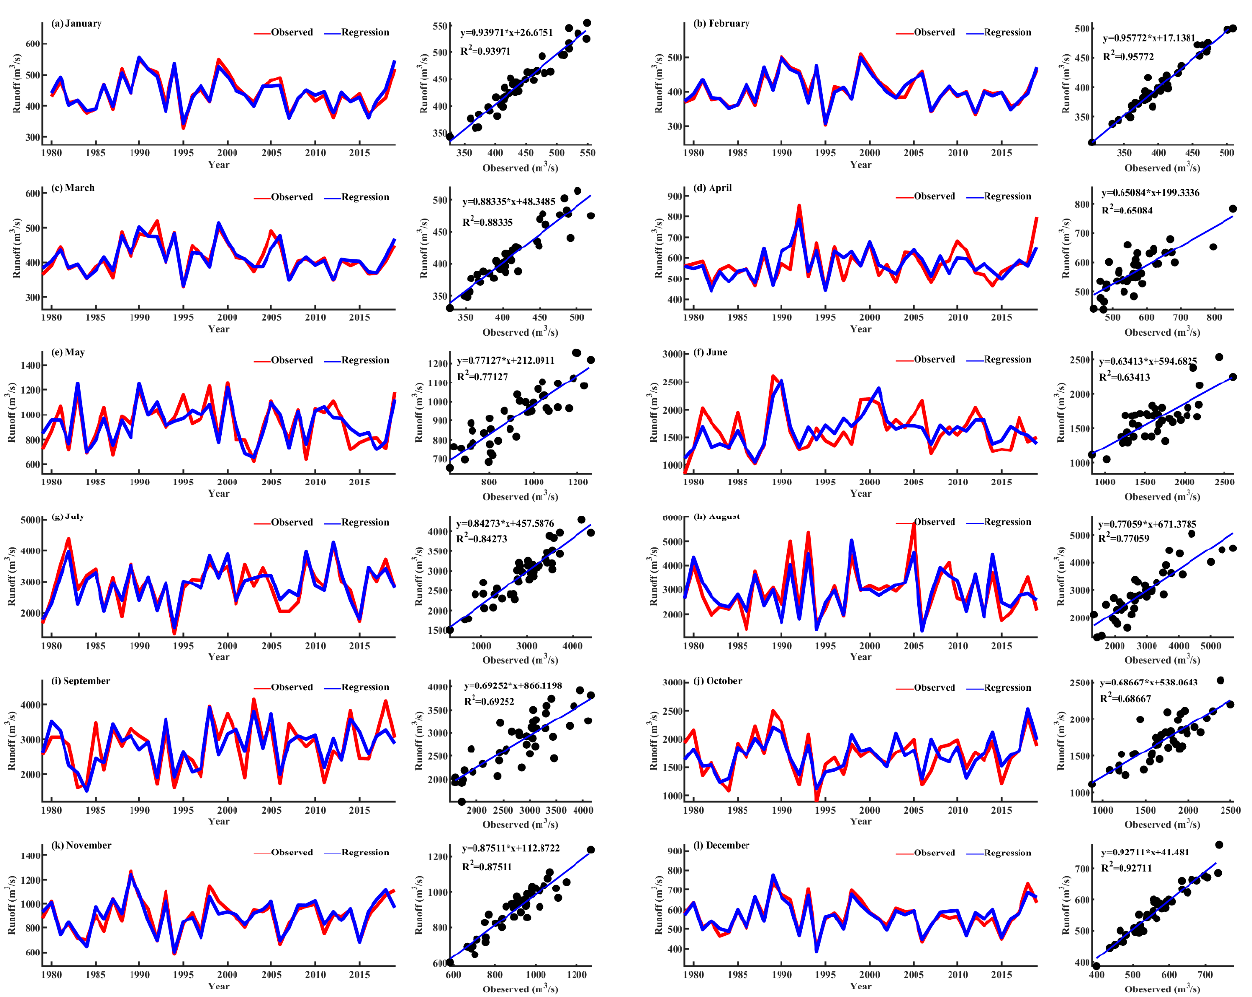
Figure 10. Simulation of multi-factor regression model for different months at Shigu station (April– October is the key area factor).